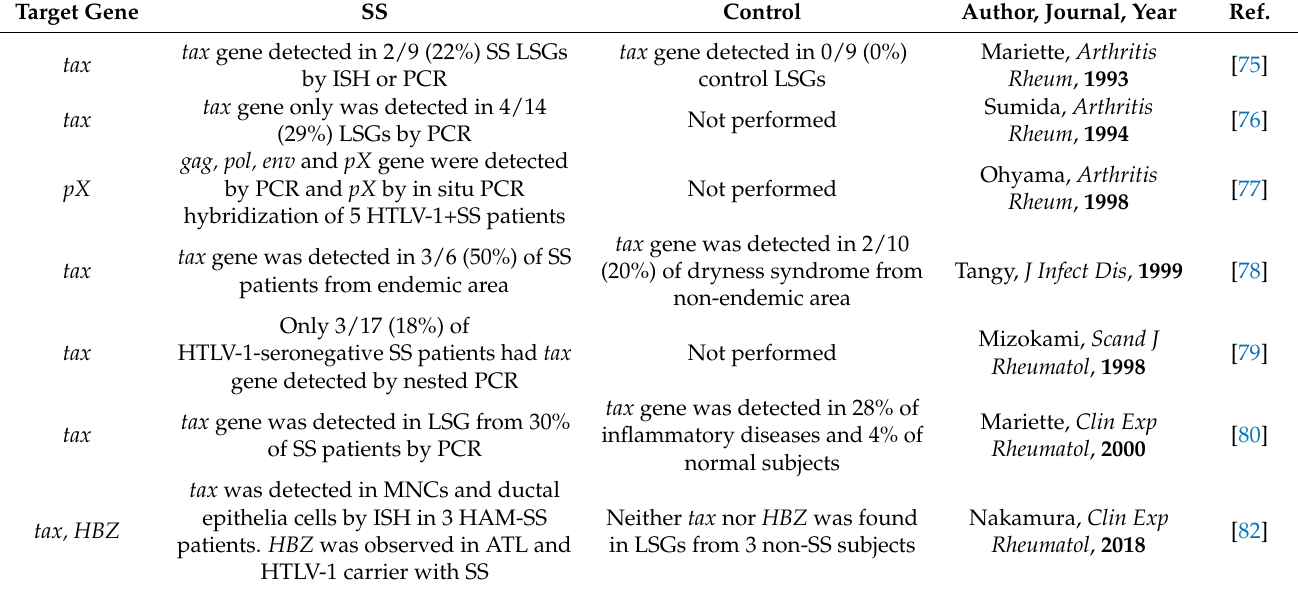
Table 1. Confirmation of HTLV-1-related genes in LSGs from patients with Sjögren’s